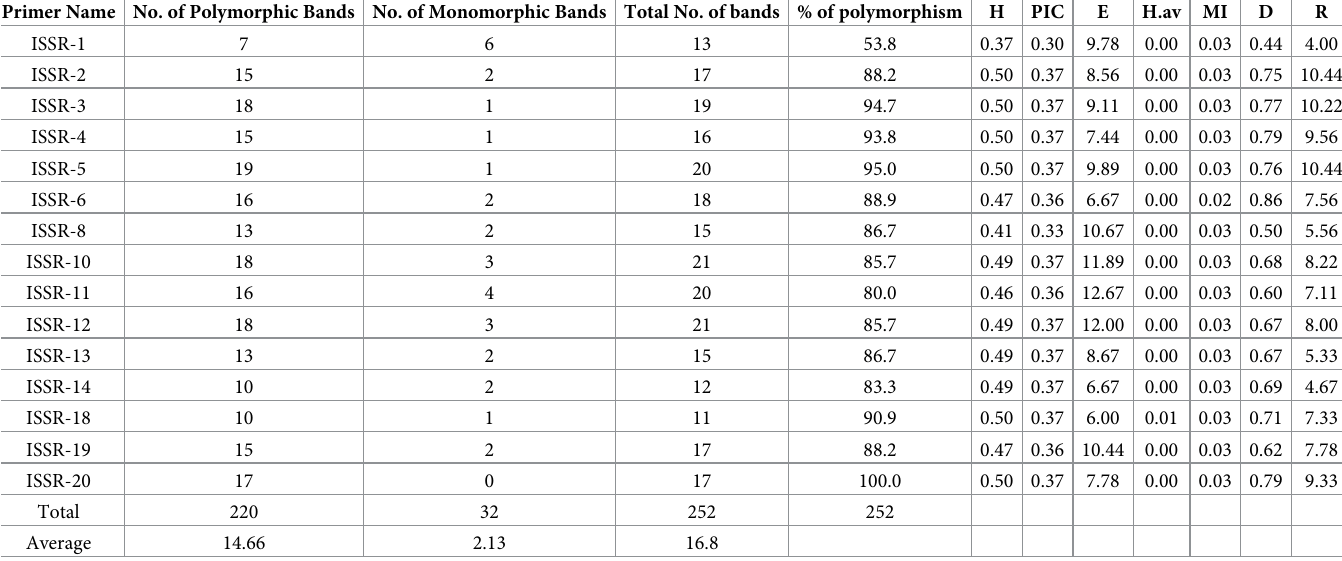
Table 6. Primer names, number of total bands, polymorphic bands, percentage of polymorphism and markers efficiency parameters of ISSR